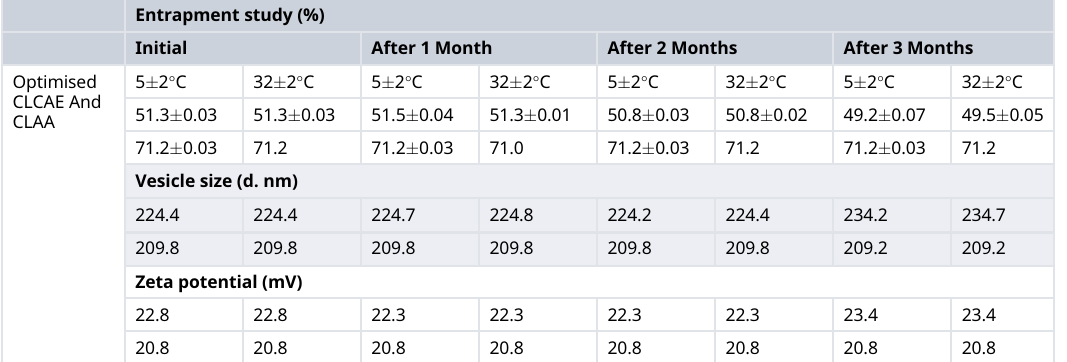
Table 6. Stability study of the optimised CLCAE and CLAA by considering entrapment efficiency, vesicle size, and